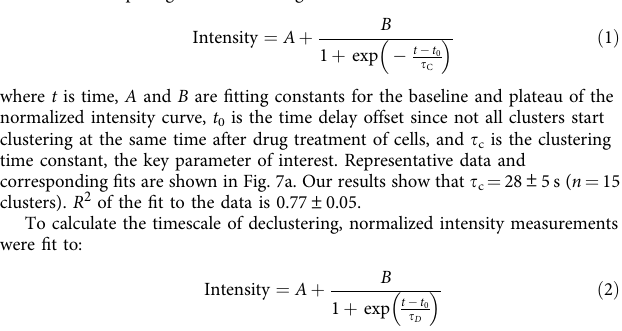
Methods Cell culture and experiments . MDA-MB-231 cells expressing fluorescent actin filaments (LifeAct) were cultured at 37 (cid:2) C, 5% CO 2 with DMEM supplemented with 10% foetal bovine serum and 1% penicillin-streptomycin. Cells were a gen- erous gift from the Lauffenburger Lab. These cells were used because they are highly active and contractile, features that we are interested in and are important in cancer progression 6,65 . During experiments cells were plated on 2D glass-bottom wells. After 1 day of incubation, cells were then treated with 2.5 m M Cytochalasin D (Sigma-Aldrich) or 1 m M Latrunculin A (Sigma-Aldrich). The concentrations of drugs were chosen such that their impact on cell mechanical properties is around maximal saturating levels 56,66 . Cells were imaged with a spinning disk confocal